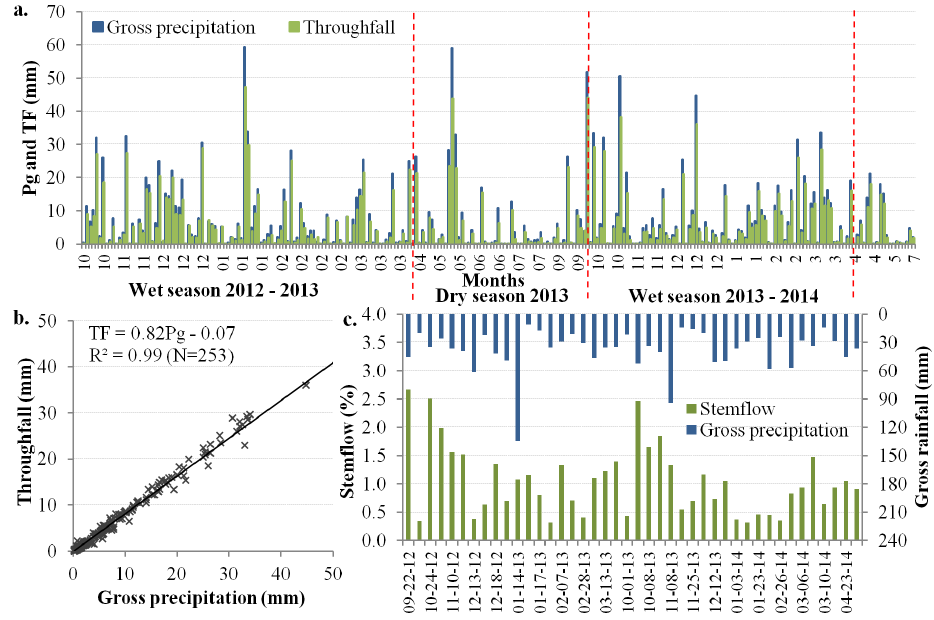
Figure 3. (a) Gross precipitation and throughfall for each rain event measured from October 2012 to July 2014. Dotted lines in red show the beginning and the end of dry seasons (April–September). (b) Scatter plot of throughfall against gross precipitation. (c) Gross precipitation and stemflow measured from September 2012 to May 2014.